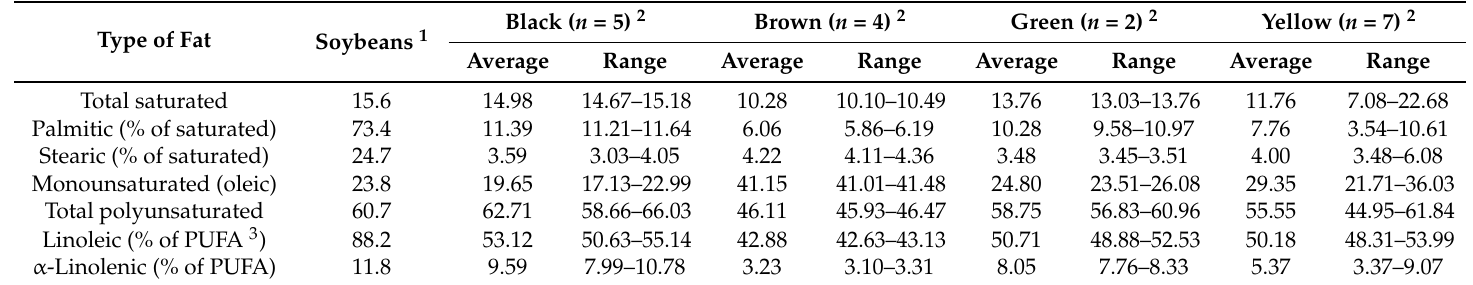
Table 2. Fatty acid composition of soybean oil by seed coat color (grams per 100 g of